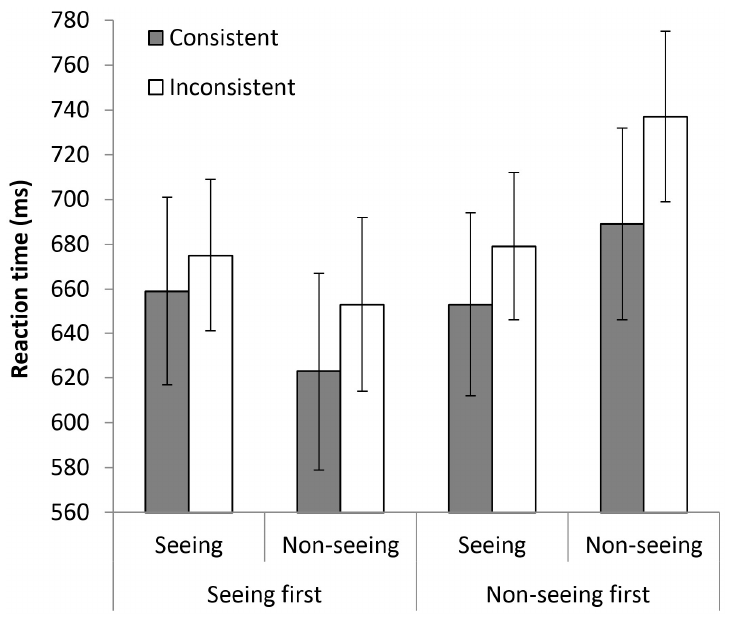
Figure 4. Mean RTs obtained in Experiment 2 as a function of visibility, consistency and block order. Error bars represent the standard error of the mean.